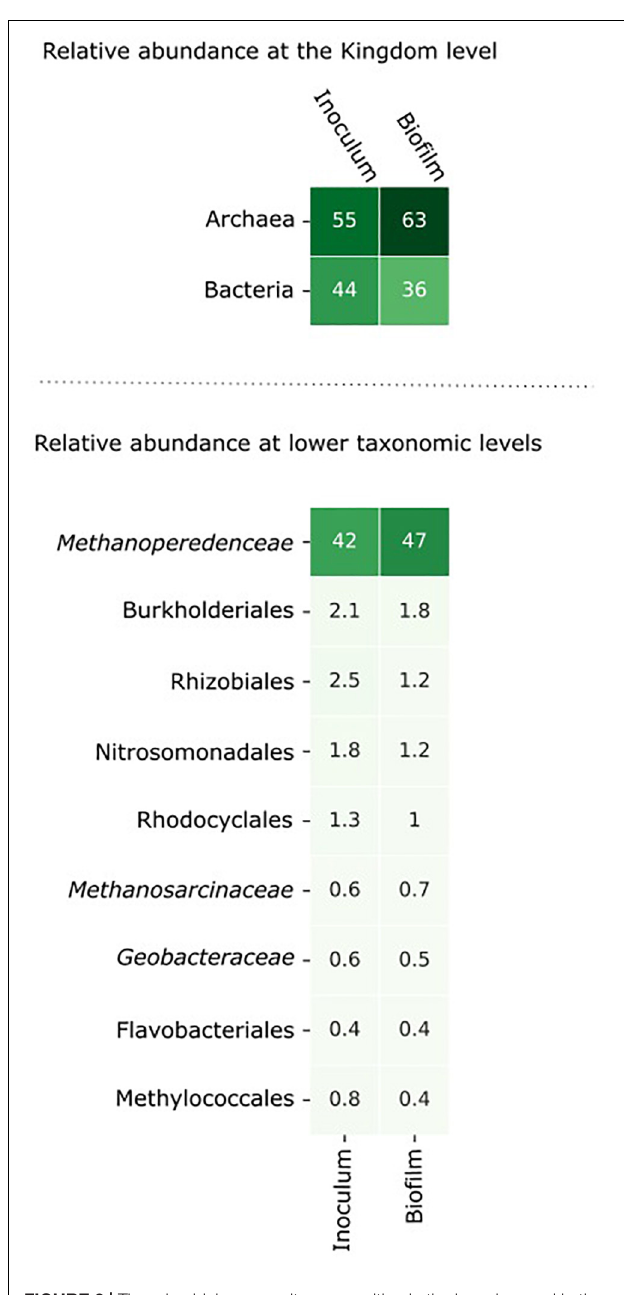
FIGURE 3 | The microbial community composition in the inoculum and in the biofilm at the anode after 8 days of incubation. The relative abundance of the microorganisms was assessed by assigning metagenomic sequencing reads to taxonomic ranks using Kraken2 (Wood et al., 2019) at the nucleotide level and Kaiju (Menzel et al., 2016) at the amino acid level. Microorganisms with an abundance > 0.5% in either the inoculum or the biofilm are shown in the figure.